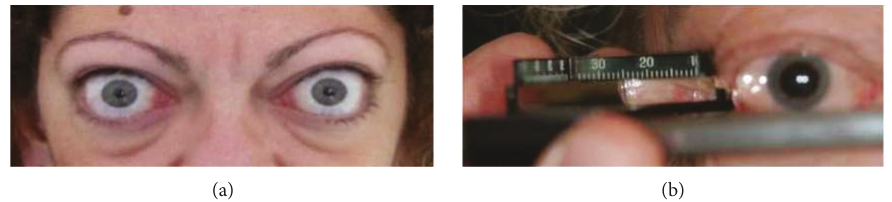
Figure 1: Patient with Graves ’ disease and orbitopathy showing a severe proptosis (a) as assessed by Hertel exophthalmometry